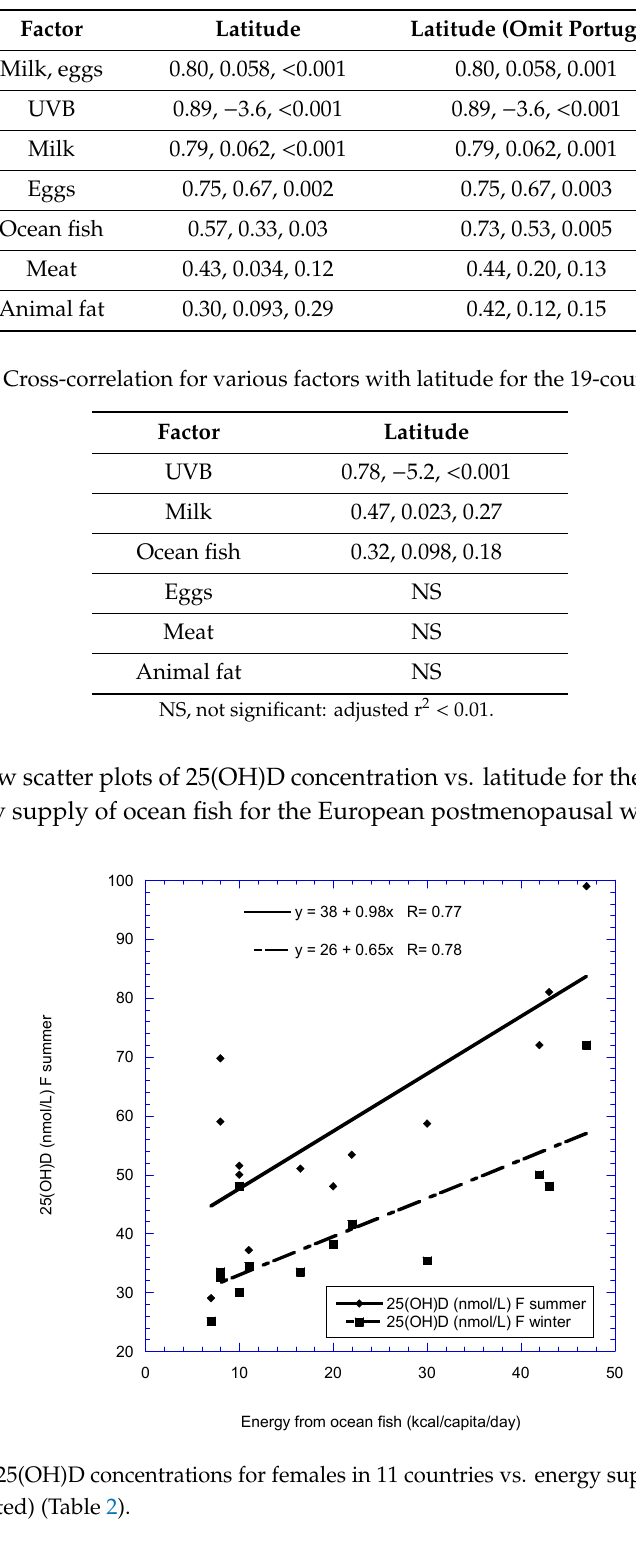
Latitude (deg N) Figure 2. Plot of 25(OH)D concentration vs. latitude for the 19-country European postmenopausal women’s study [22]. Formatted: Not Highlight